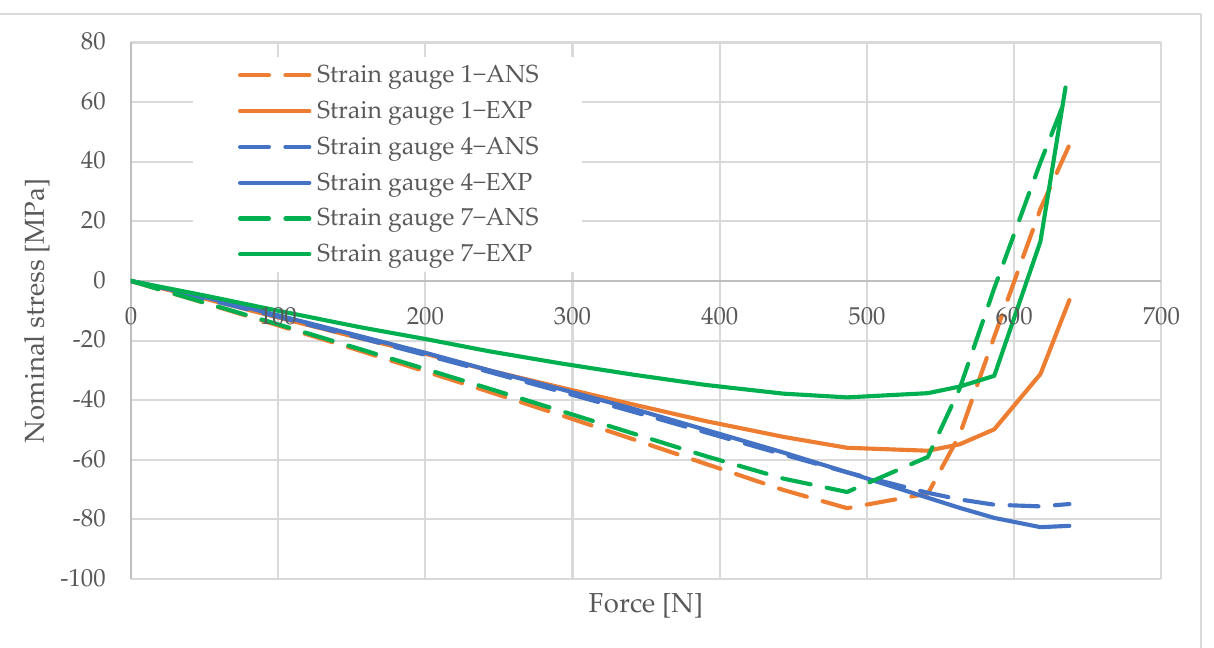
Figure 11. Pole 5/2 — values of normal stress readings from strain gauges no. 11 and 12.